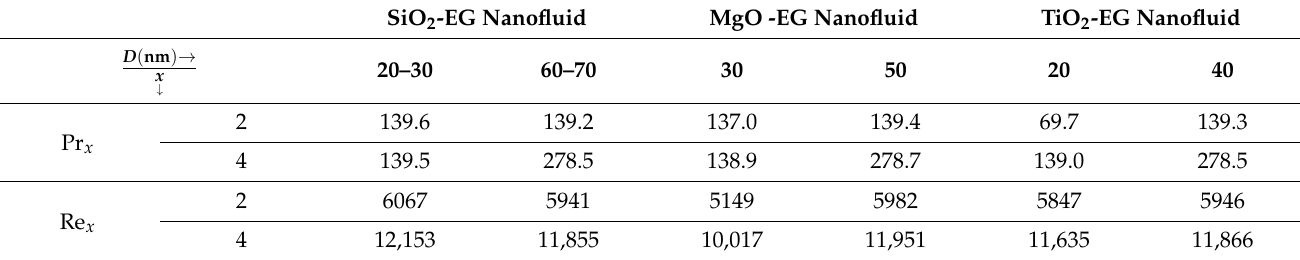
Table 5. The values of Pr x and Re x numbers at different nanoparticle diameters.